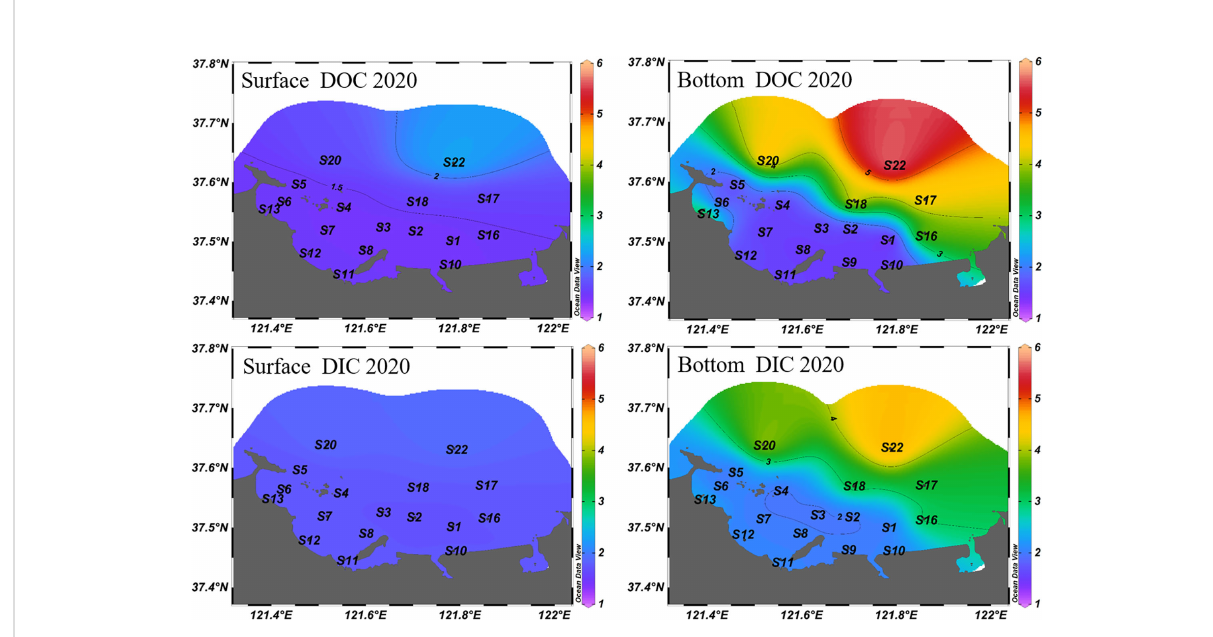
FIGURE 2 Spatial distribution of the DOC and DIC (unit: mg/L) in the YOA in August 2020 for surface seawater, and bottom